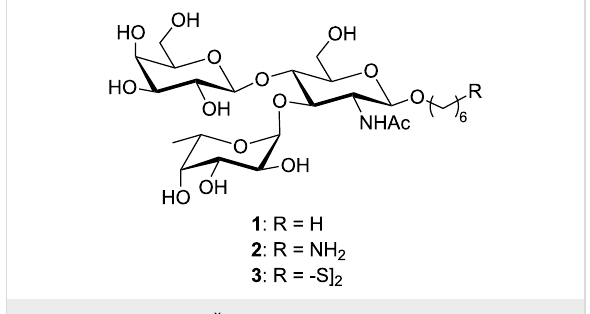
Figure 1: Structure of Le x analogues 1 – 3 .